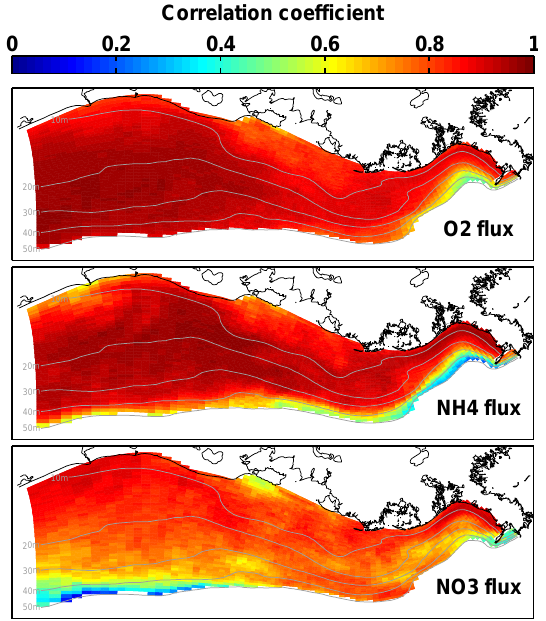
Figure 6. Correlation coefficients between time-dependent diage- netic model simulations and the parameterized fluxes for each loca- tion on the Louisiana